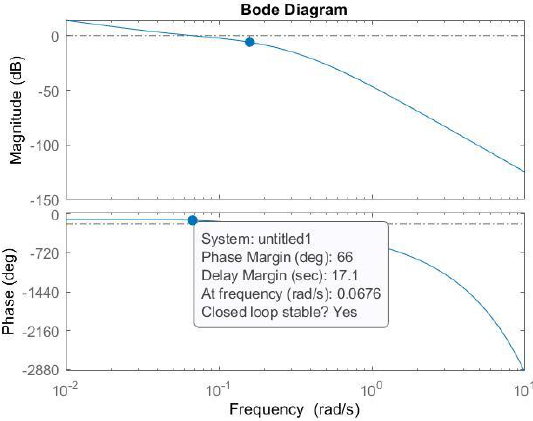
Figure 3. Bode diagram of the open-loop system for the second designed PI controller.